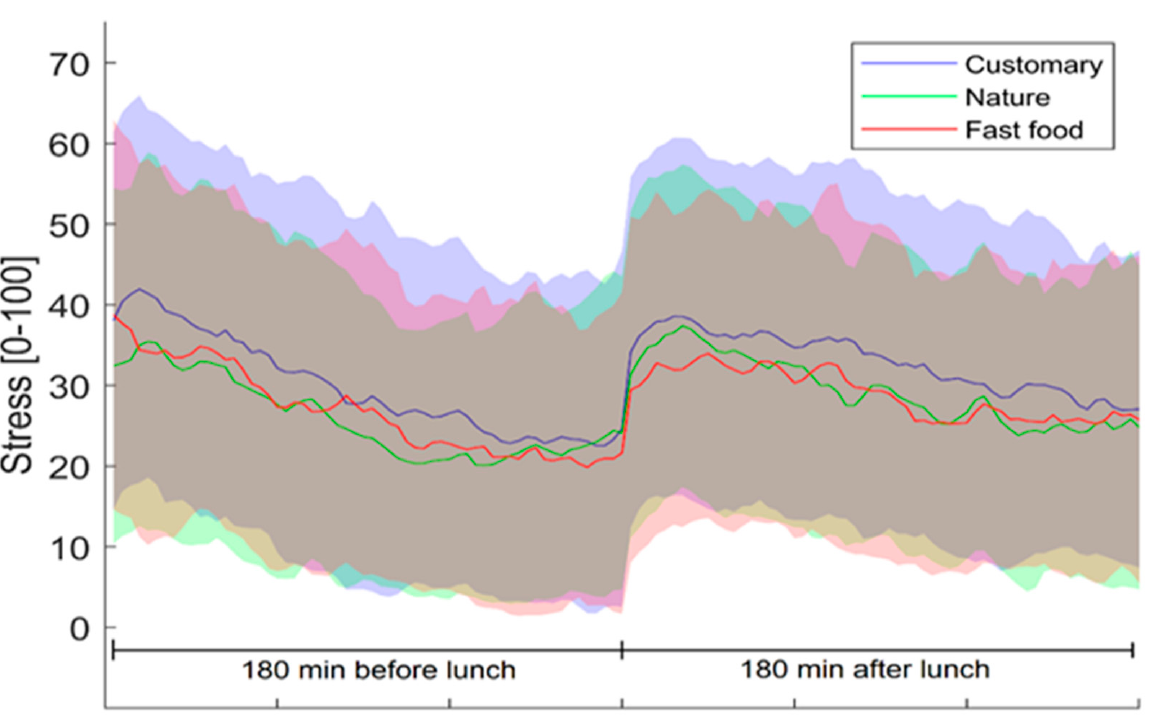
Figure 4. Evolution of objective stress over time in different ambiences on a scale in which 0–25 = resting state, 26–50 = low stress, 51–75 = medium stress, 76–100 = high stress. Solid lines show averages and shaded areas show standard deviations. Data from the subgroup of participants ( n = 32).